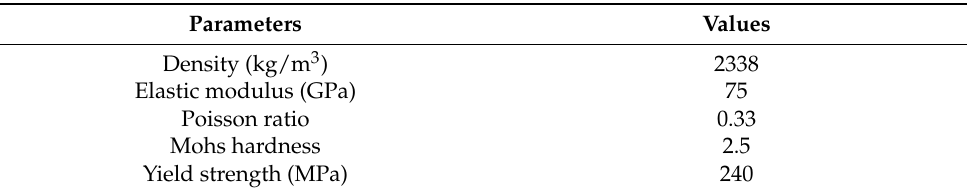
Table 3. Mechanical parameters of the KDP crystal.